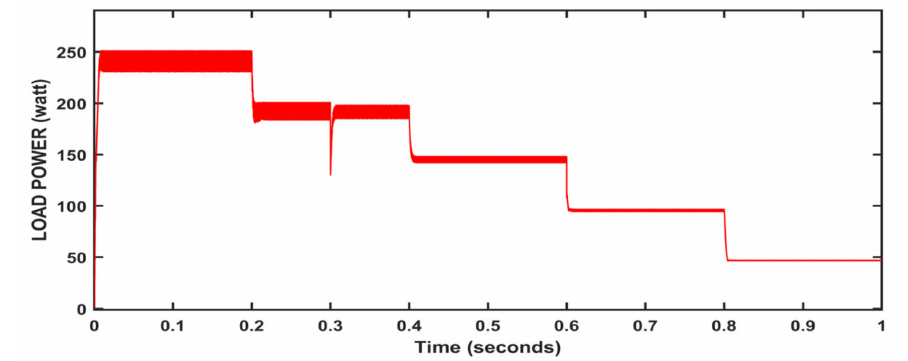
Figure 16. Algorithm performance under variable irradiations and varying loads.